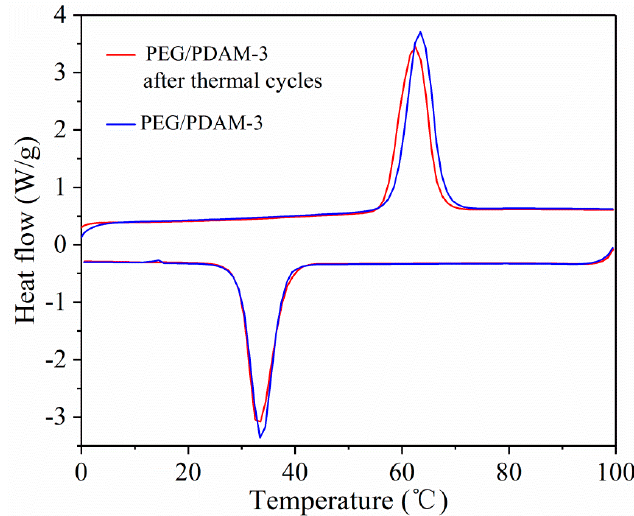
Figure 10. DSC curves of PEG/PDAM-3 before and after the thermal cycle.